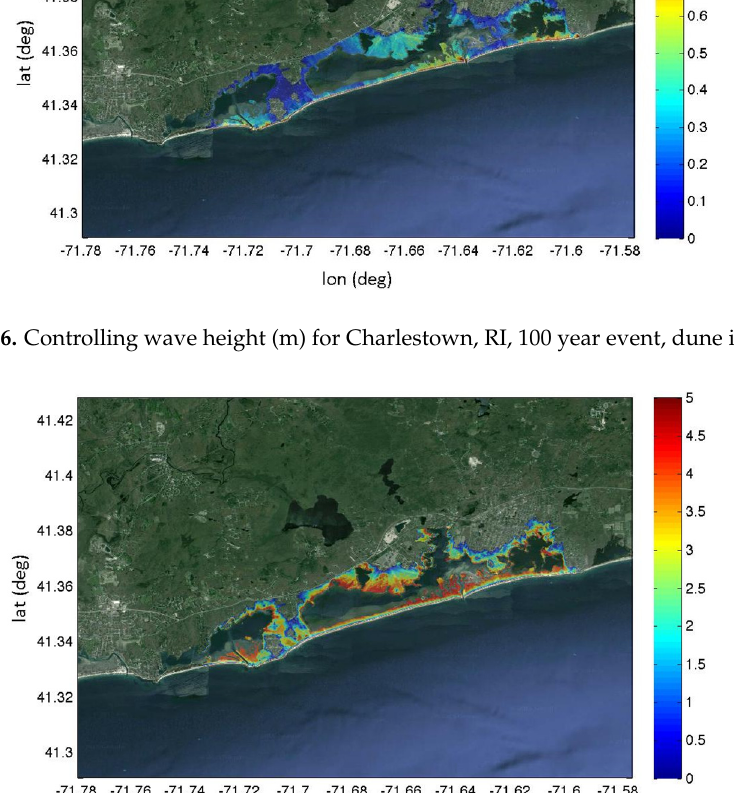
Figure 7. Total water depth (m) (inundation plus controlling wave height) for Charlestown, RI, 100 year event, dune intact.